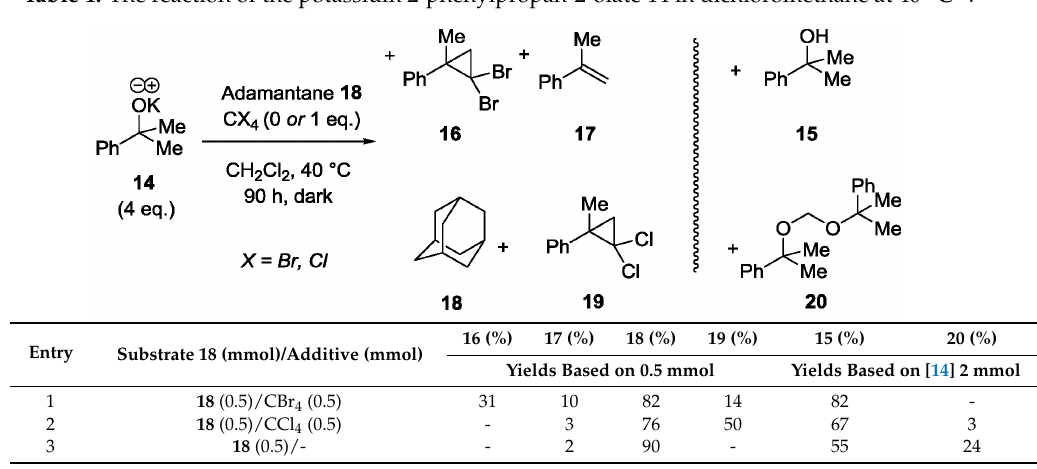
Table 1. The reaction of the potassium 2-phenylpropan-2-olate 14 in dichloromethane at 40 °C a